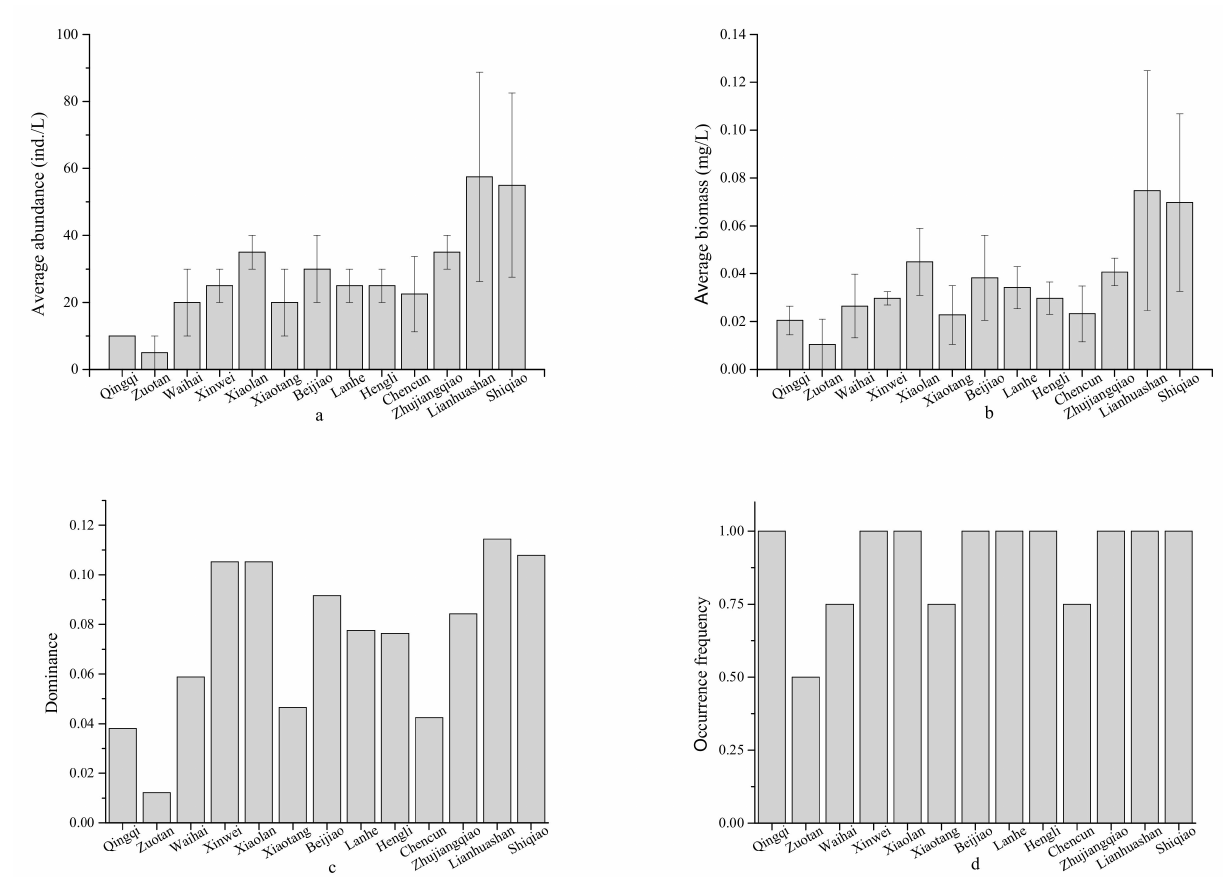
Figure 4. Spatial distribution of the ecological characteristics of Brachionus calyciflorus . ( a ) Average abundance; ( b ) average biomass; ( c ) average dominance; ( d ) average occurrence.